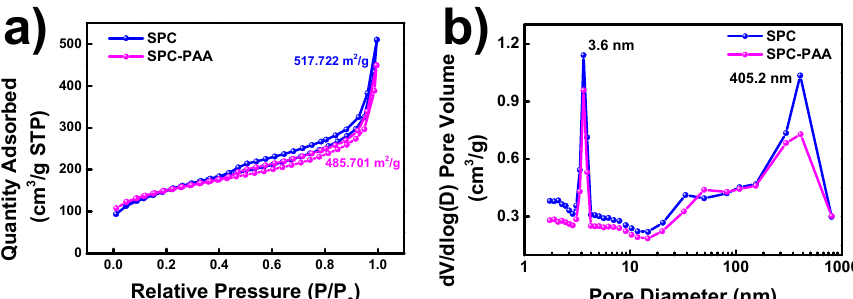
Figure 3. N 2 adsorption–desorption isotherms ( a ) and pore diameter distributions ( b ) of N-SPCs ( a ) and PAA/N-SPCs.